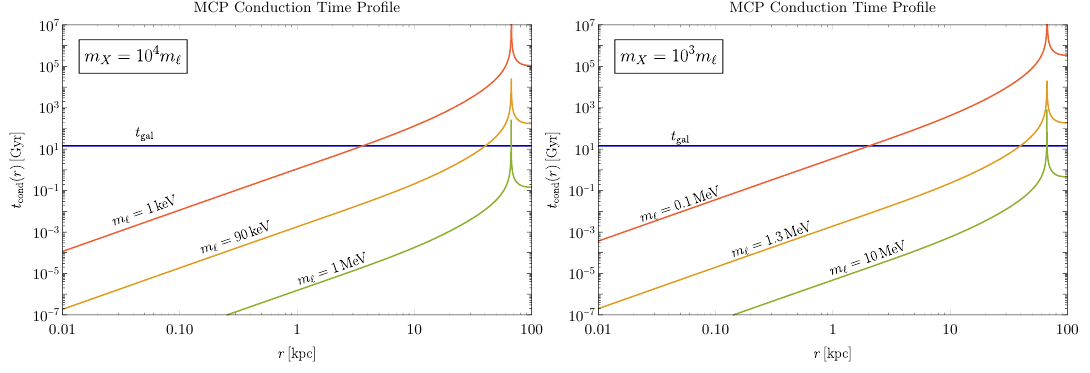
Figure 8 . The conduction timescale in the MCP plasma as a function of the radius, with t gal for comparison. t cond was computed in section 4.2 using the adiabatic halo density and temperature in eqs. (A.7) and